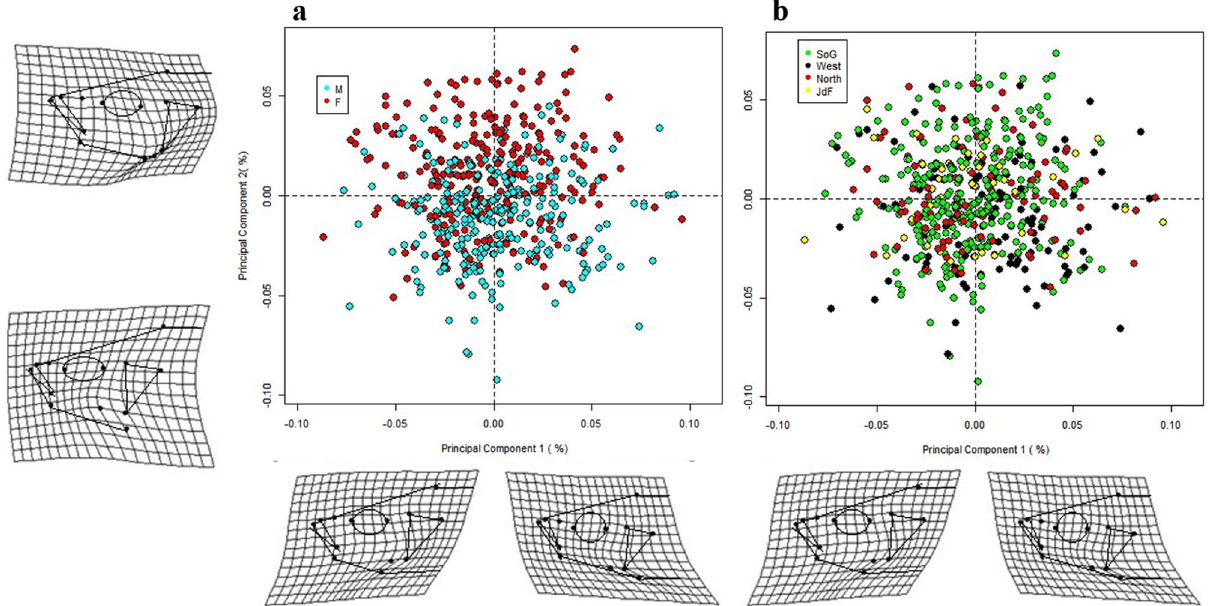
Figure 3. Principal Component Analysis (PCA) of head shape. The head shape for each specimen was obtained from a set of thirteen anatomical landmarks, shown in the methods section (Fig. 6). The landmarks were converted into 26 shape variables using a Generalized Procrustes Analysis (GPA). These variables were used to carry out the PCA. Deformation grids were plotted with 1.5 × magnification to facilitate visualization of head shape differences. The deformation grids represent the difference between the specimen on each end of each shape axis (PC1 and PC2). The effects of body size were removed from this analysis. ( a ) Each data point represents data from a female stickleback (red circles) and male stickleback (light blue circles). ( b ) Each data point represents data from the four oceanographic regions that surround Vancouver Island, BC: Strait of Georgia (green), west coast Vancouver Island (black), north coast Vancouver Island (red), and the Juan de Fuca Strait (yellow).